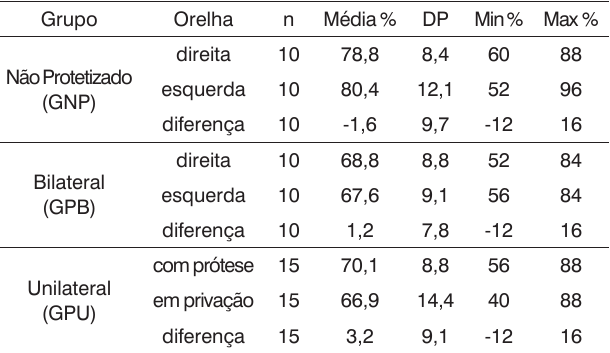
Tabela 1. Média dos valores do IRF e desvio padrão (DP) para cada orelha e para as diferenças (em porcentagem), para os três grupos. Valores Mínimos (Min) e Máximos (Max) são disponibilizados.